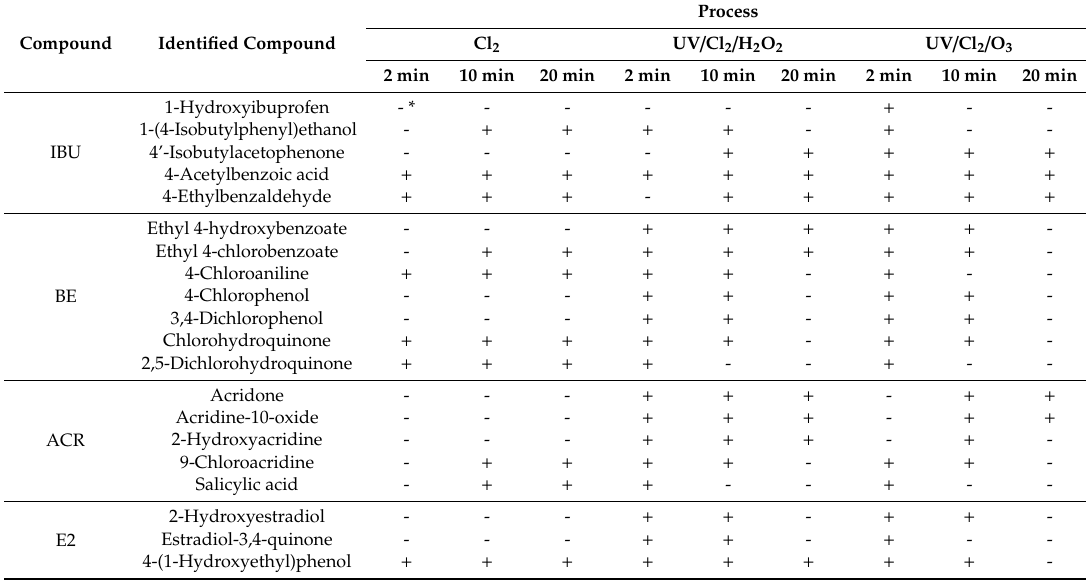
Table 2. CECs by-products identified in selected processes during the performed experiments.